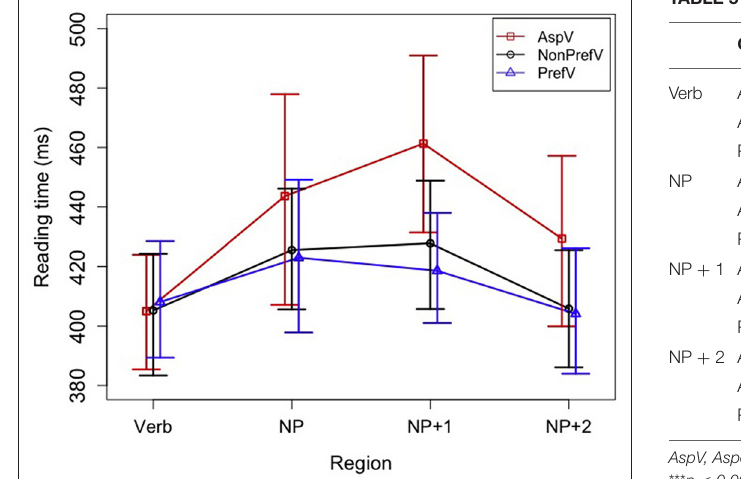
TABLE 5 | Results of pairwise comparisons for the main effect of verb type.